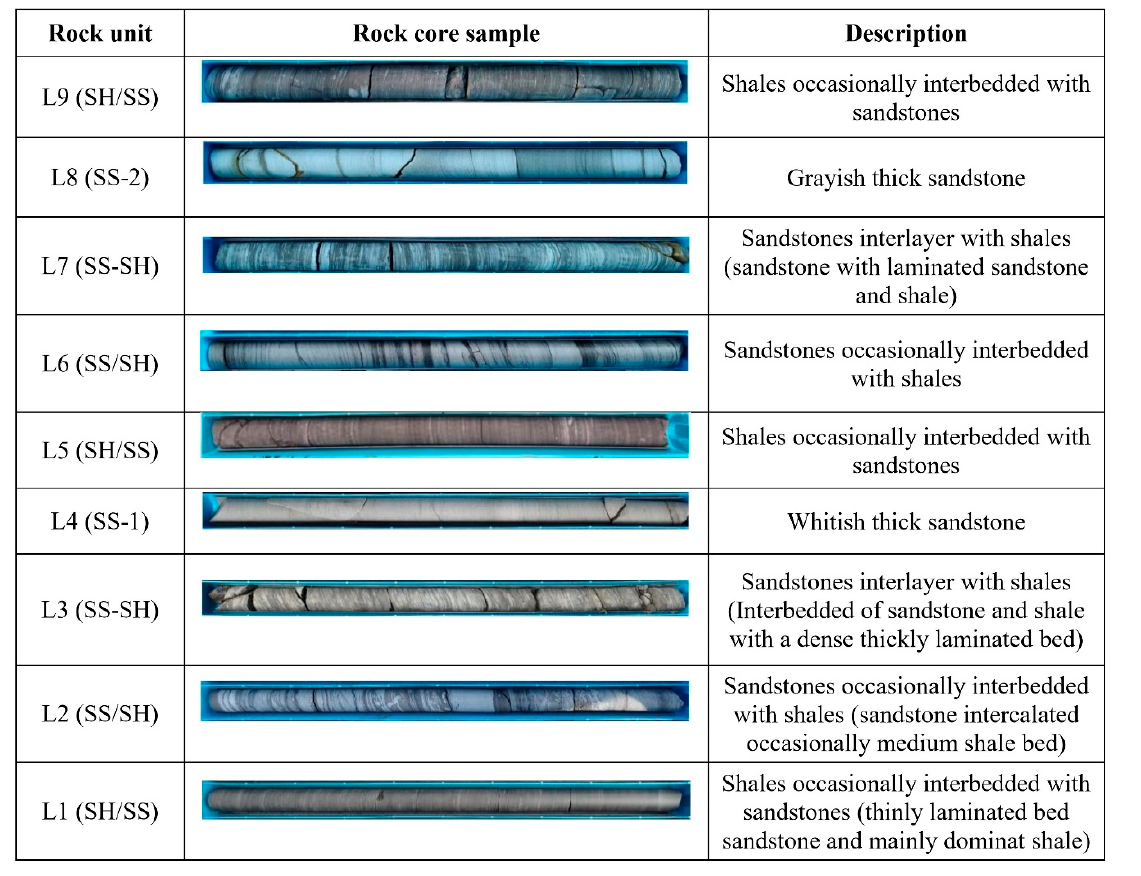
Figure 6. Typical rock cores for the nine rock units and description of the characteristics of each rock unit. The thick sandstone (L4) was used as a key bed for the polynomial regression of surface fitting.